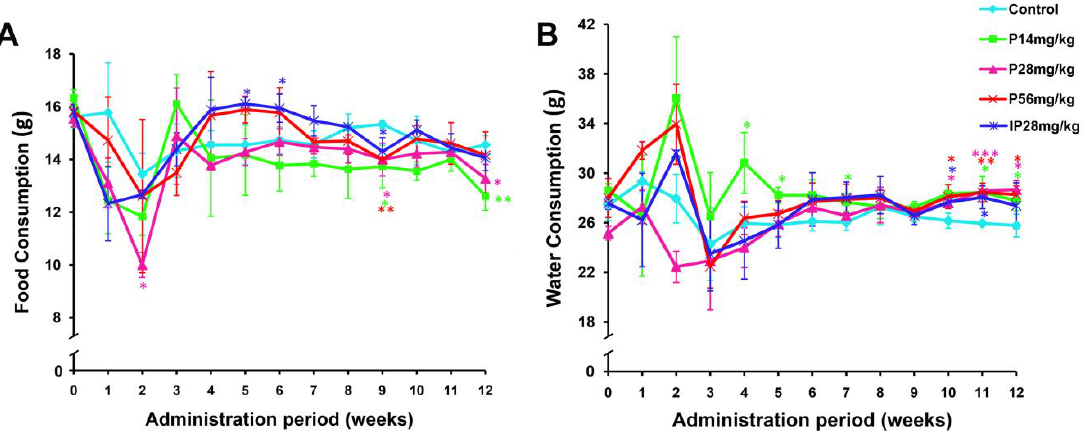
Figure 2. The rats’ food and water intake within 3 months’ repeated administration of psoralen or isopsoralen. ( A ) Food consumption. ( B ) Water consumption. Data represented as mean ± SD. * P < 0.05, ** P < 0.01, *** P < 0.001, significant di ff erence from control rats.